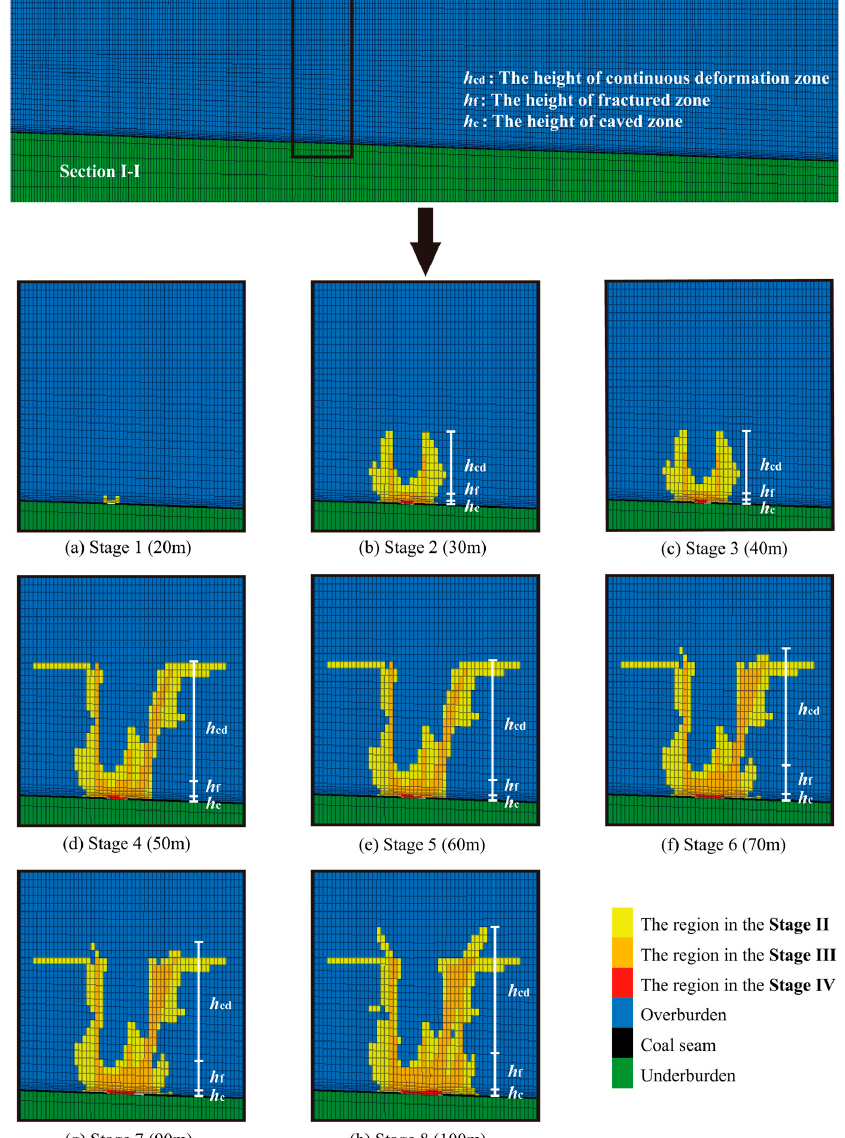
Figure 14. Dynamic evolution laws of the four zones due to excavation (20–100 m).